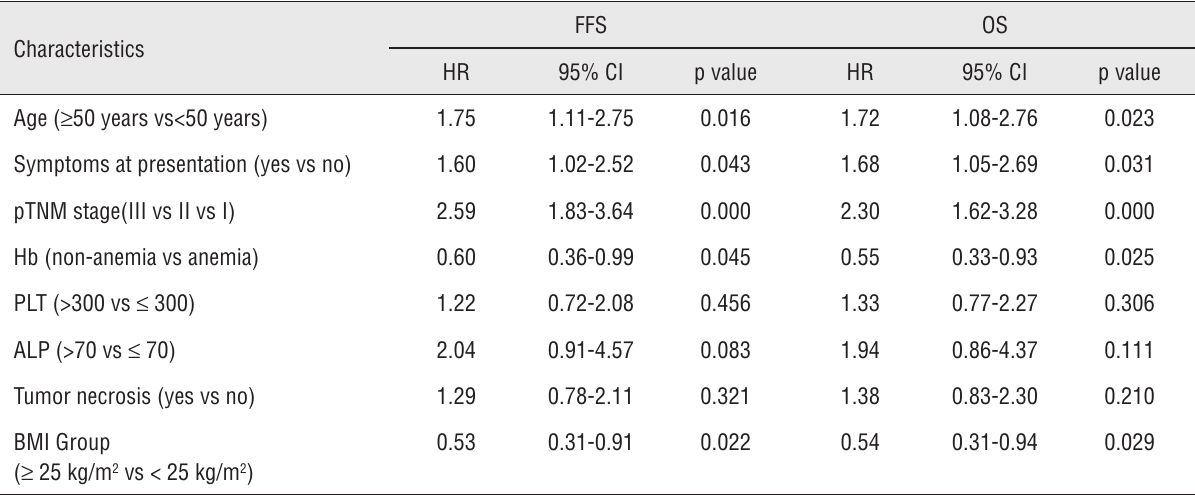
Table 3 - Pretreatment BMI Effect on Different Endpoint: Multivariate Analysis in Cox Regression Model.